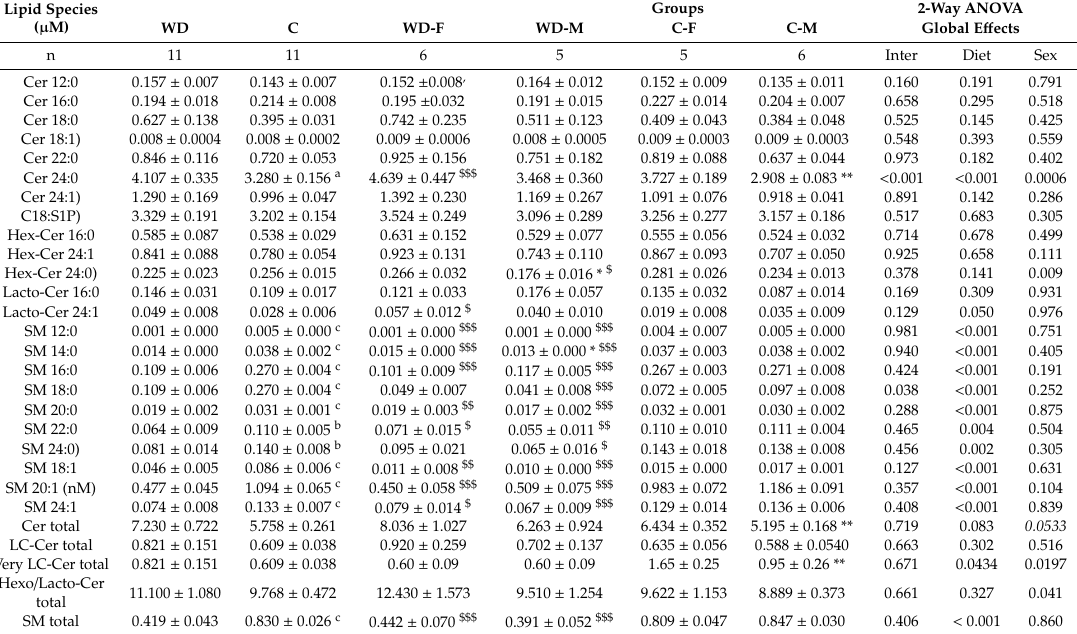
Table 3. Concentrations ( µ M, except for SM 20:1 expressed in nM) of sphingolipids (SPLs) in blood of male and female o ff spring at day 25 of lactation period and suckled by dams fed control or western diet. Lipid Species ( µ M)